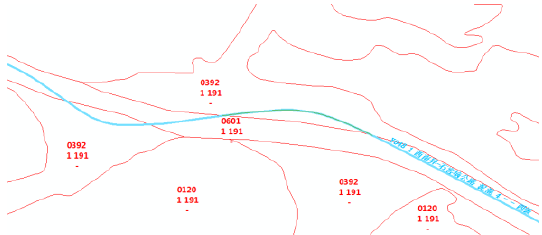
Figure 3. Road and background data highway element acquisition accuracy